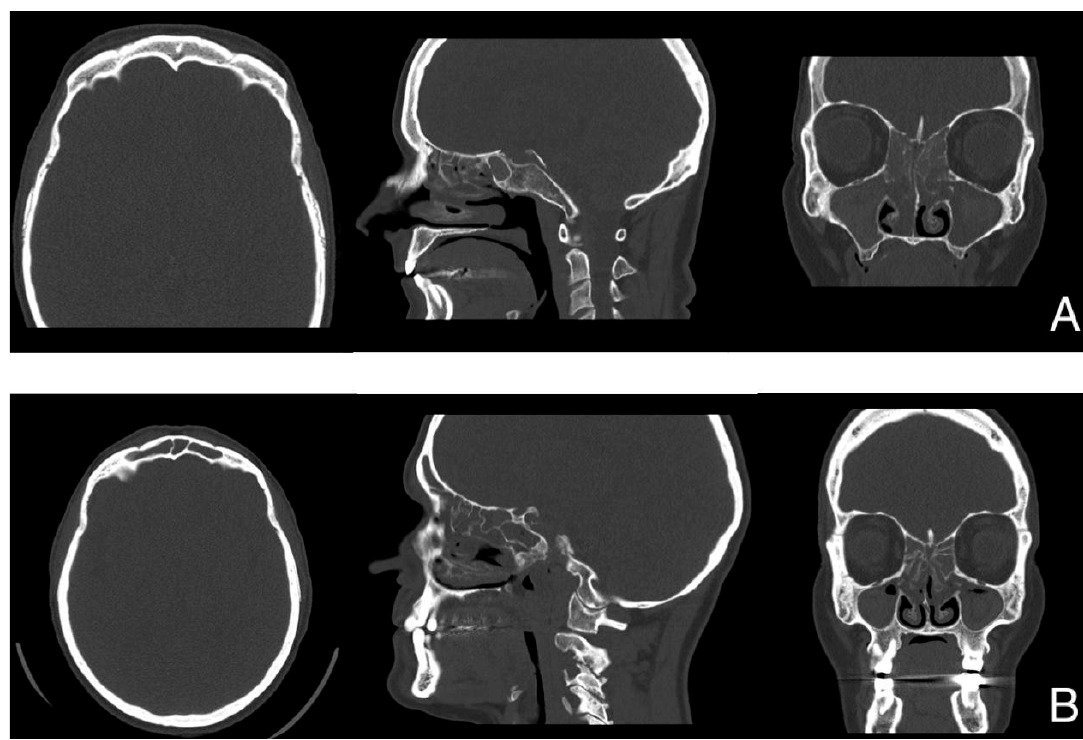
Figure 1. CT scans prior to surgery. ( A ) = patient #1 (frontal sinuses aplasia, LM = 18/20); ( B ) = patient #2 (LM = 22/24).